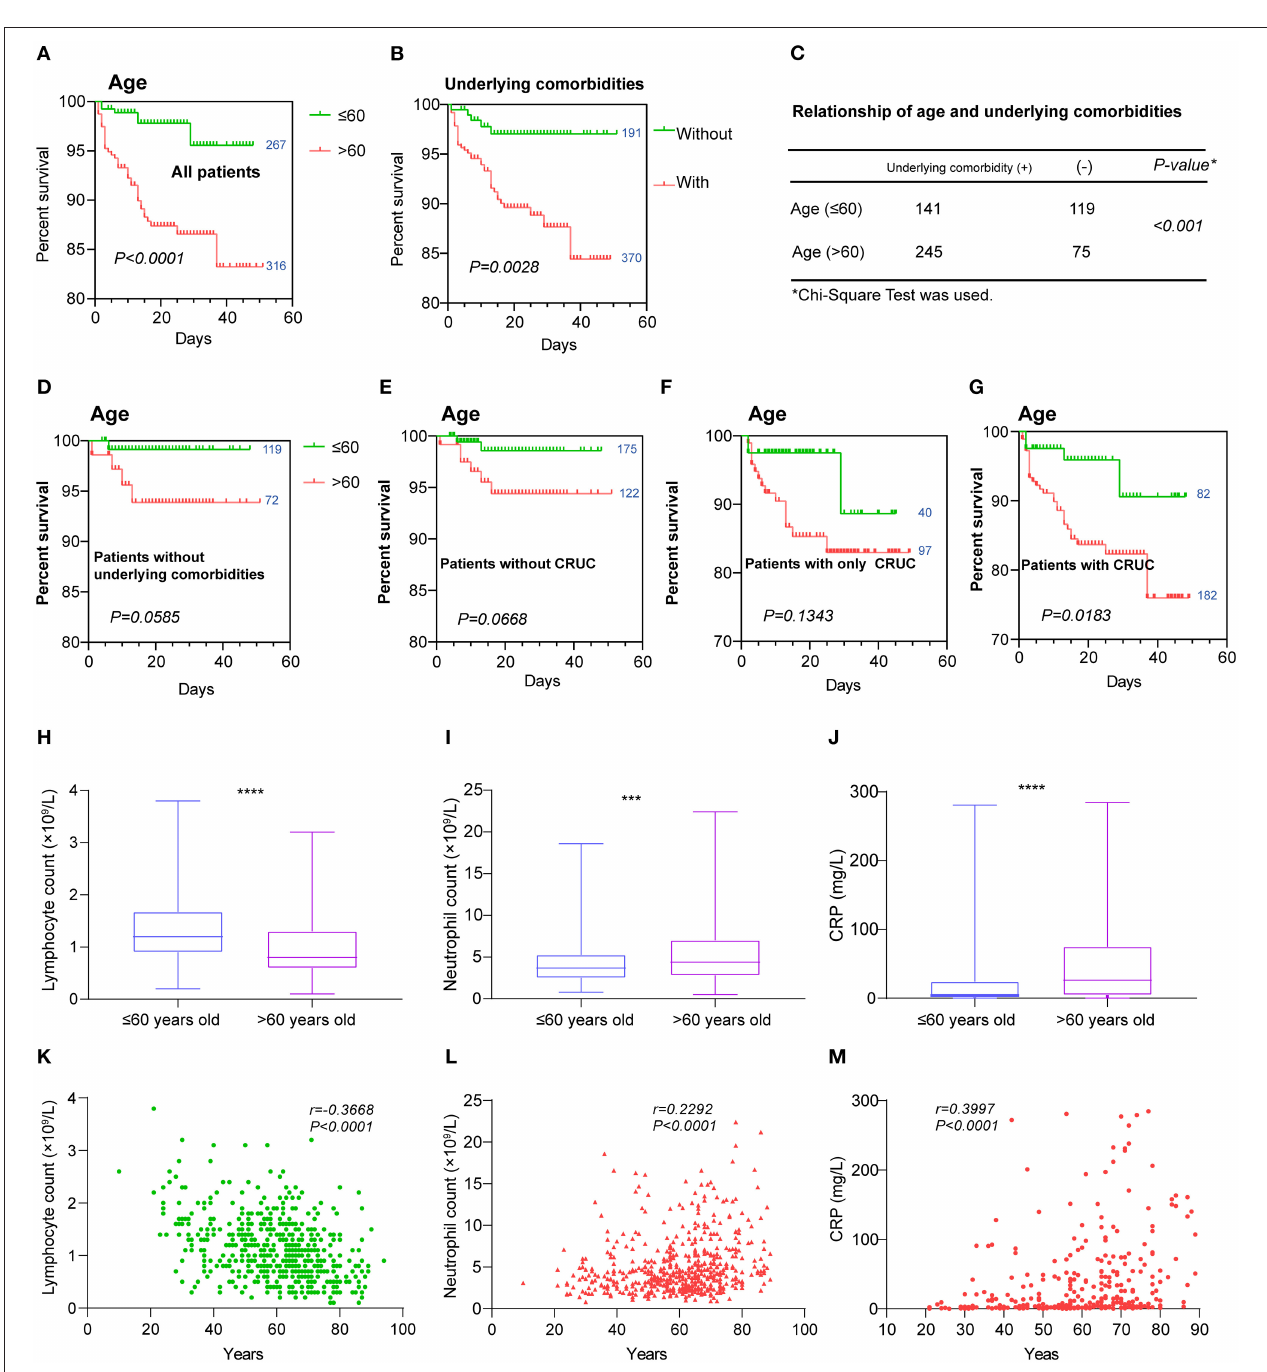
FIGURE 6 | Hematologic variations between the young and old. Kaplan–Meier survival curves for (A) age and (B) underlying comorbidities are shown. (C) The relationship of age and underlying comorbidities was analyzed by chi-square test. Kaplan–Meier survival curves for age in those patients (D) without any underlying comorbidities, (E) those without cardiovascular-related comorbidities, (F) those with only cardiovascular-related underlying comorbidities, and (G) those with cardiovascular-related underlying comorbidities. Hematologic indices that were found to have different levels between the young and old including (H) lymphocytes, (I) neutrophils, and (J) CRP and were also correlated with age (K–M) . Data are shown as boxes and whiskers. Correlations are colored by positive (red) or negative (green). The numbers next to the survival curves indicate quantities of patients in such a group. *** P < 0.001 and **** P < 0.0001.